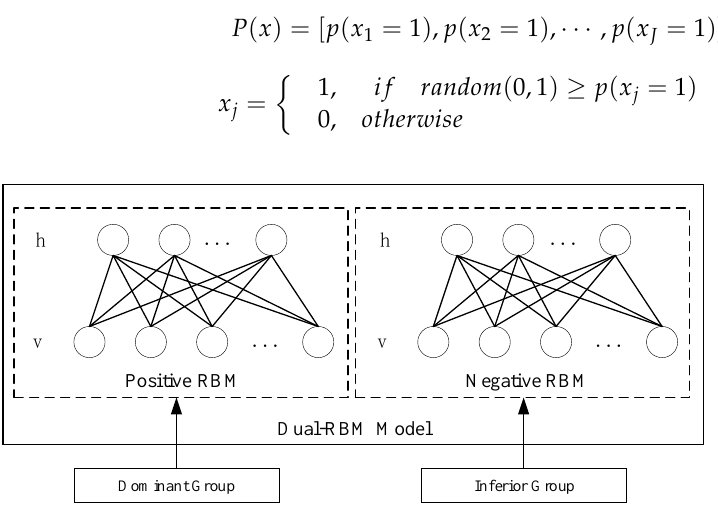
Figure 1. Structure of the Dual-RBM